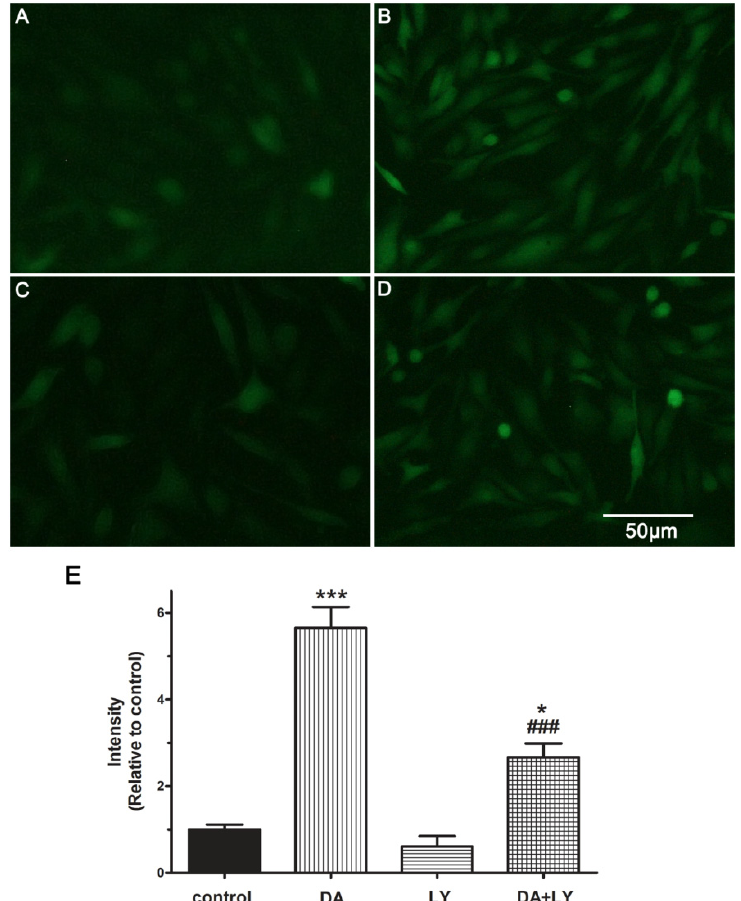
Figure 7. DA (20 μ M) stimulated NO production in PAECs via PI3K/Akt pathway in 10 min. DA stimulated the release of NO product ( B ) and LY294002 (LY 10 − 6 M) reduced NO production in PAECs ( C ) compared with the control group ( A ). However, LY could also reduce the stimulation of DA on NO production significantly ( D ). Results are presented as the mean ± SEM ( n = 5) ( E ). * p < 0.05 and *** p < 0.001 compared with the control group. ### p < 0.001 versus DA